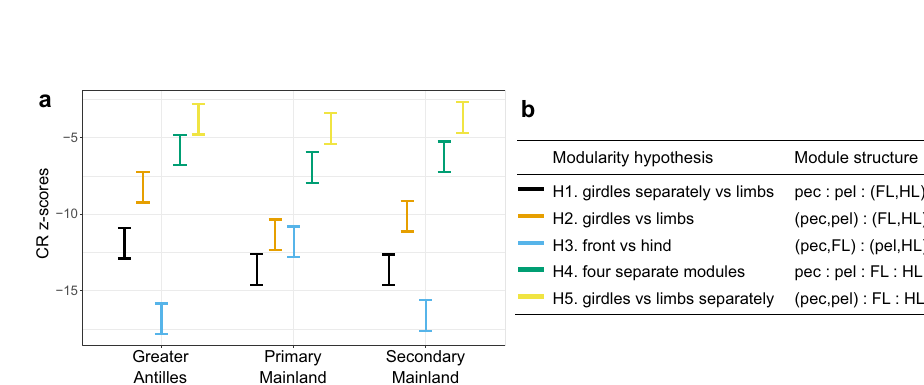
Fig. 2 Evolutionary modularity is shared between the Greater Antillean and Secondary Mainland groups while the Primary Mainland is distinct. a CR z - scores (effect sizes) of the fi ve alternative modularity hypotheses, evaluated separately for the three major groups. CR z -scores that are more negative signify a stronger modularity (i.e., stronger covariation within modules relative to the covariation between modules). CR z -scores are derived from a permutation approach (here, 1000 iterations) to derive an empirical null distribution against which the observed CR value of each con fi guration is compared (see “ Methods ” for more details). b Con fi gurations of the fi ve alternative modularity hypotheses. The modularity hypothesis H1, limbs forming a single evolutionary module, had the highest support (i.e., lowest CR z -score) in the Primary Mainland clade. In contrast, the modularity hypothesis H3 with pectoral girdle and forelimb forming a front module and pelvic girdle and hindlimb forming a hind module, had a signi fi cantly higher support (i.e., lower CR z -score) than the other hypotheses in the Greater Antillean group and the Secondary Mainland clade. For statistical support of alternative models, see Supplementary Tables 6 – 8. Abbreviations: FL forelimb, HL hindlimb, pec pectoral girdle, pel pelvic